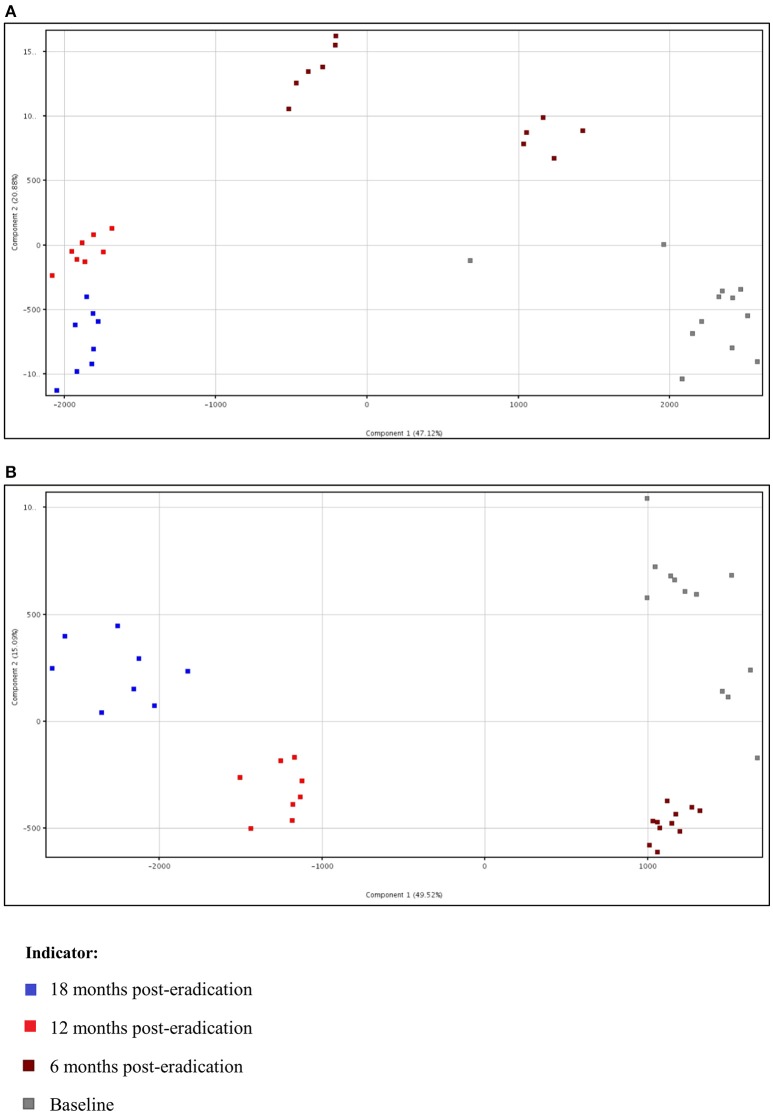
Two-dimensional PCA scores plot of fecal lipidomics for Baseline, 6, 12, and 18 months post-H. pylori eradication, acquired under both (A) positive and (B) negative ionization modes.